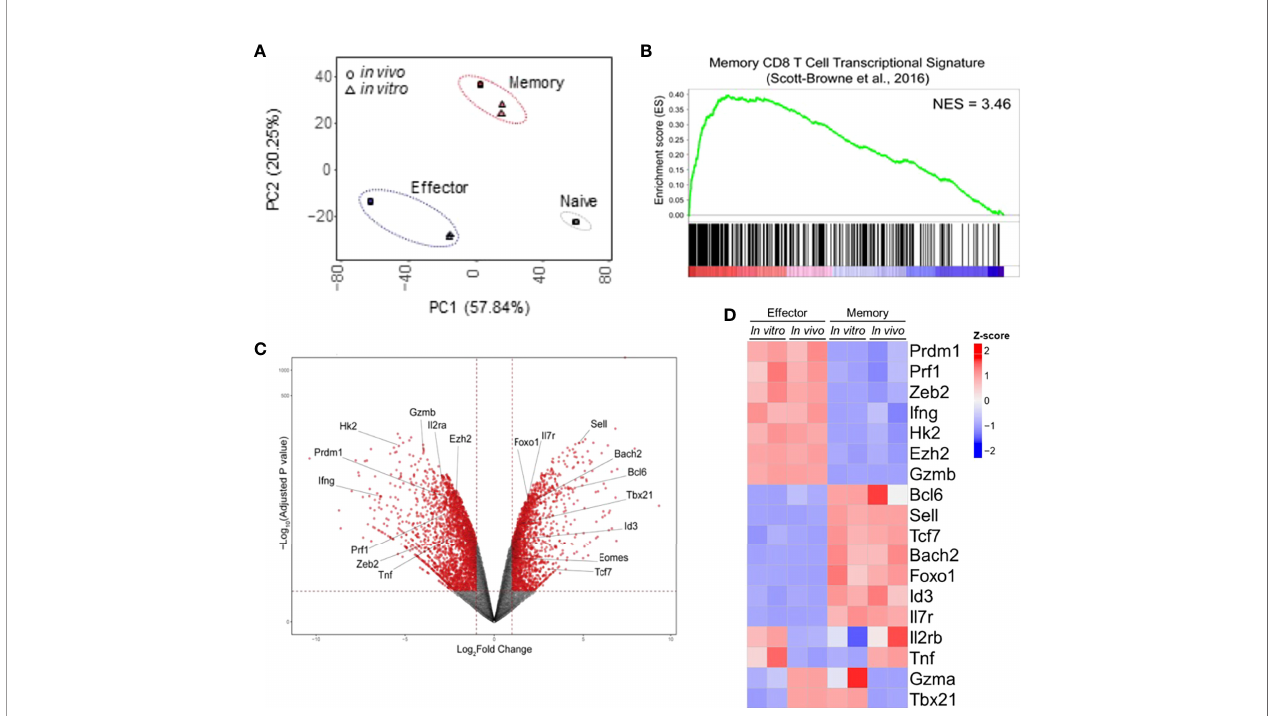
FIGURE 2 | In Vitro and In Vivo -Generated Memory and Effector CD8 T Cells Are Molecularly Similar. (A) Principal component analysis of the RNA-seq data set generated from two independent samples of memory and effector CD8 T cells obtained in vitro was performed following the protocol displayed in Figure 1 and those publicly available from cells generated upon viral infection in vivo (LCMV infection, GEO: GSE88987). (B) Gene set analysis of gene expression data described in A compared with memory CD8 T cells (22). (C) Volcano plot displaying differentially expressed genes between effector and memory CD8 T cells. (D) Heat map of differential expression between cells generated in vitro and available from in vivo model of genes commonly associated with effector or memory CD8 T cell